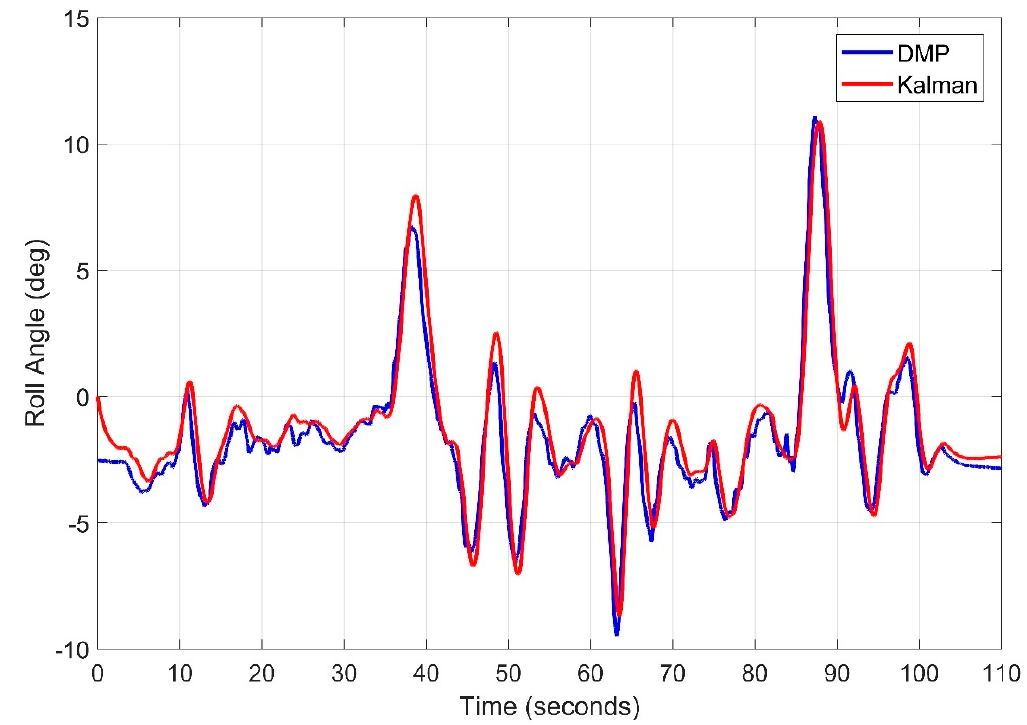
Figure 29. Real Time Roll Angle Estimate for Kalman Filter.